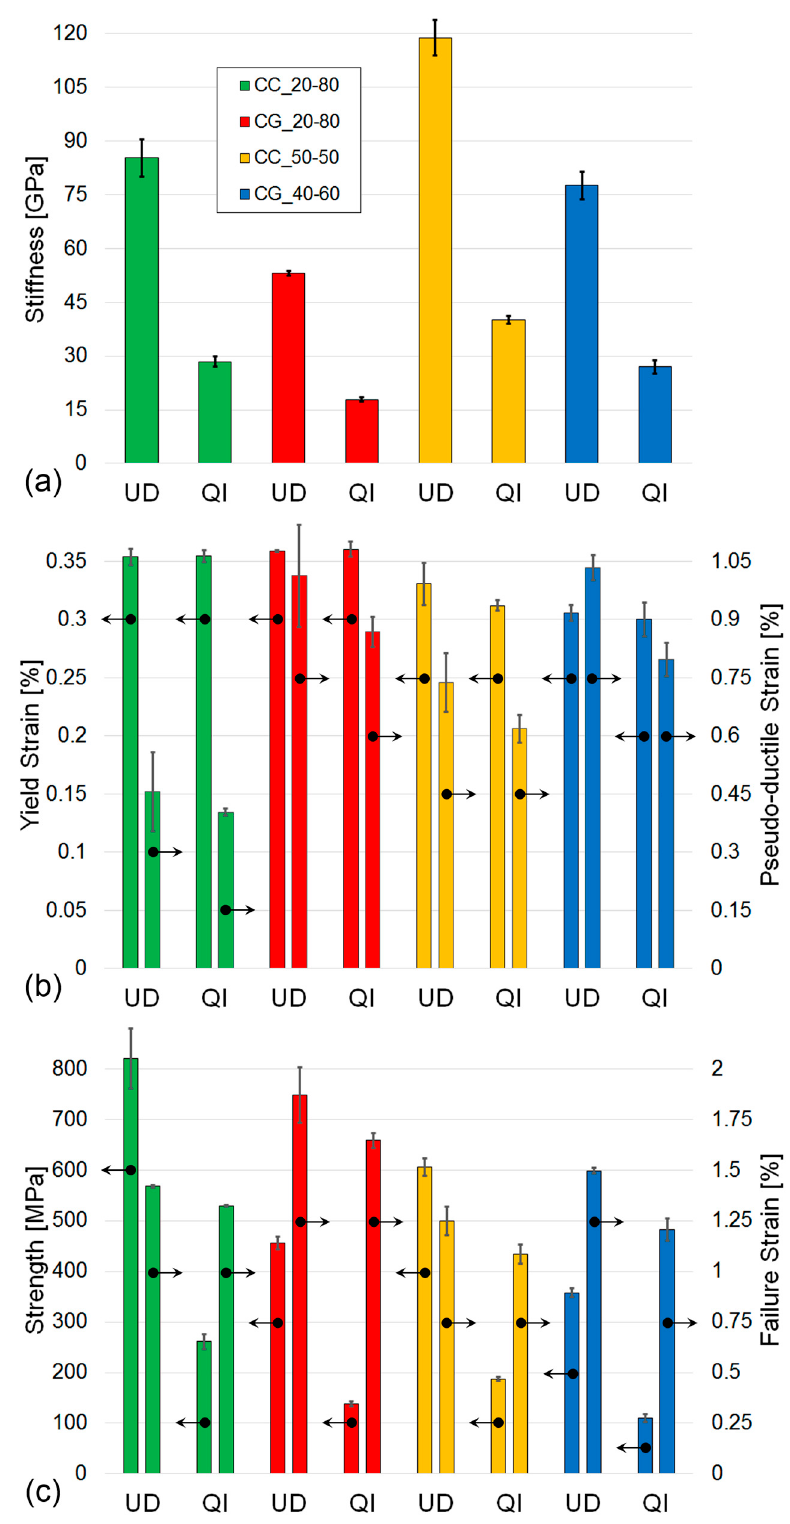
Figure 8. Pseudo-ductile ADFRCs tensile test results: ( a ) stiffness, ( b ) pseudo-ductile parameters, and ( c ) failure properties.